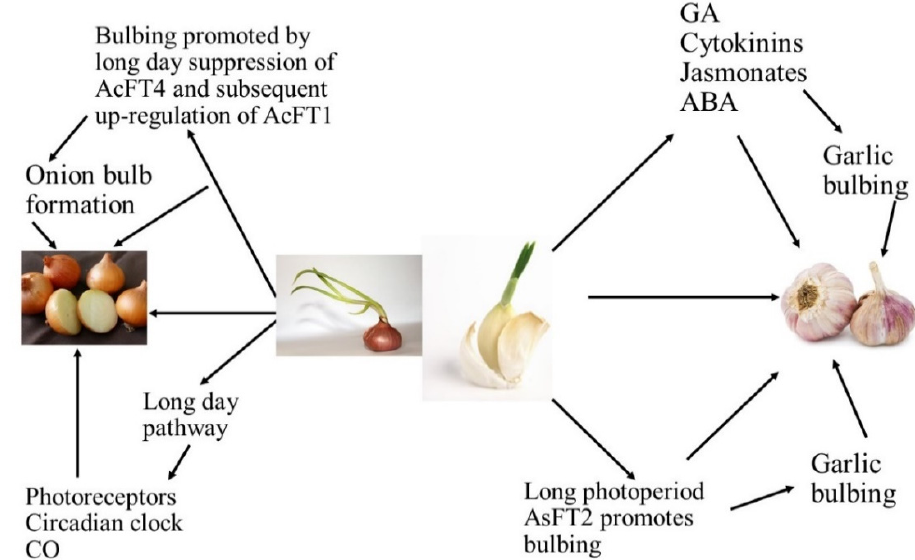
Figure 1. Schematic representation of role of photoperiod, FT-like genes, and phytohormones in Allium sativum and Allium cepa bulb formation.